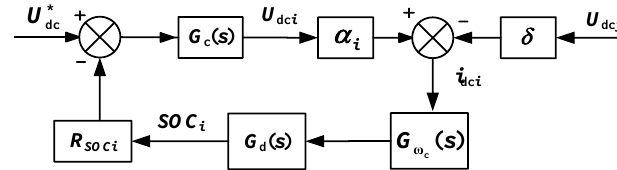
Figure 6. ∆𝑆𝑂𝐶 as a function of 𝑅 𝑆𝑂𝐶𝑖 for several factor set values.